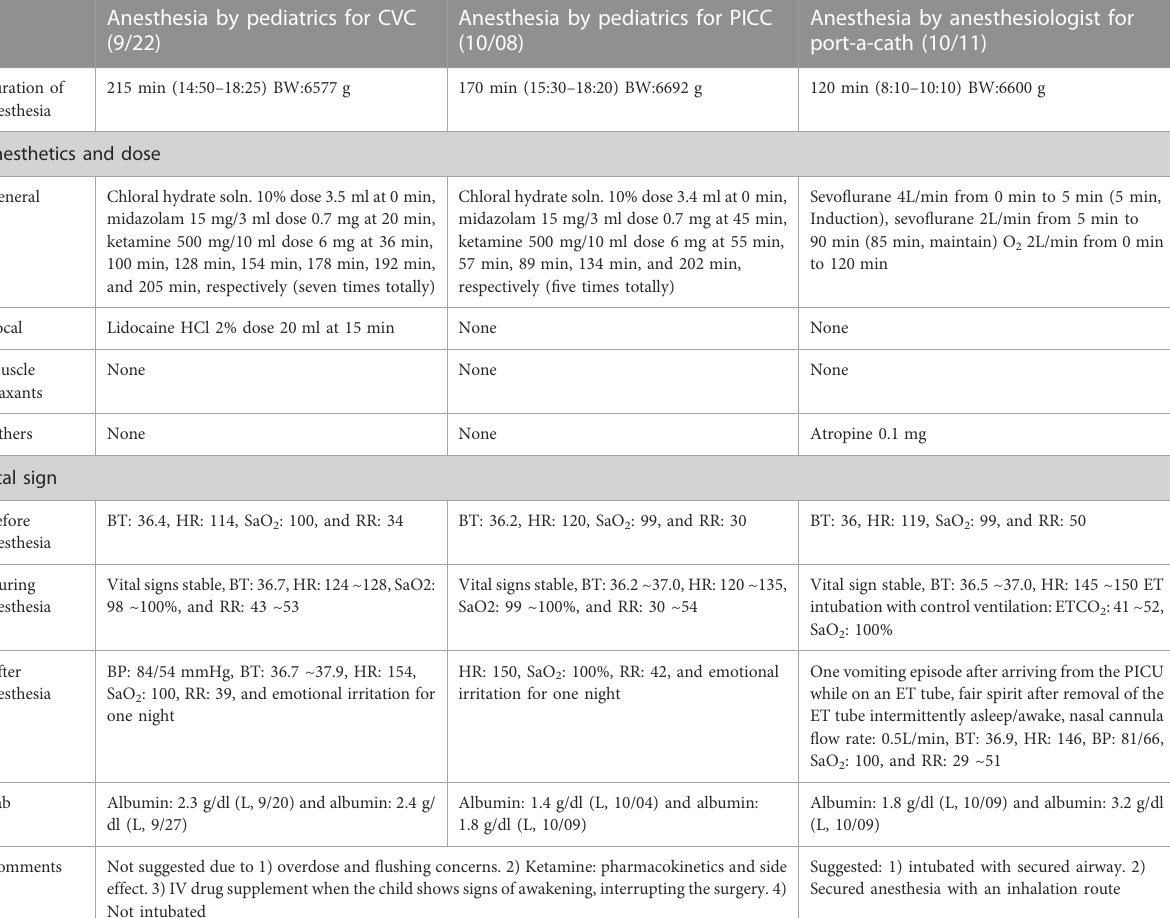
Anesthesia by pediatrics for PICC (10/08)